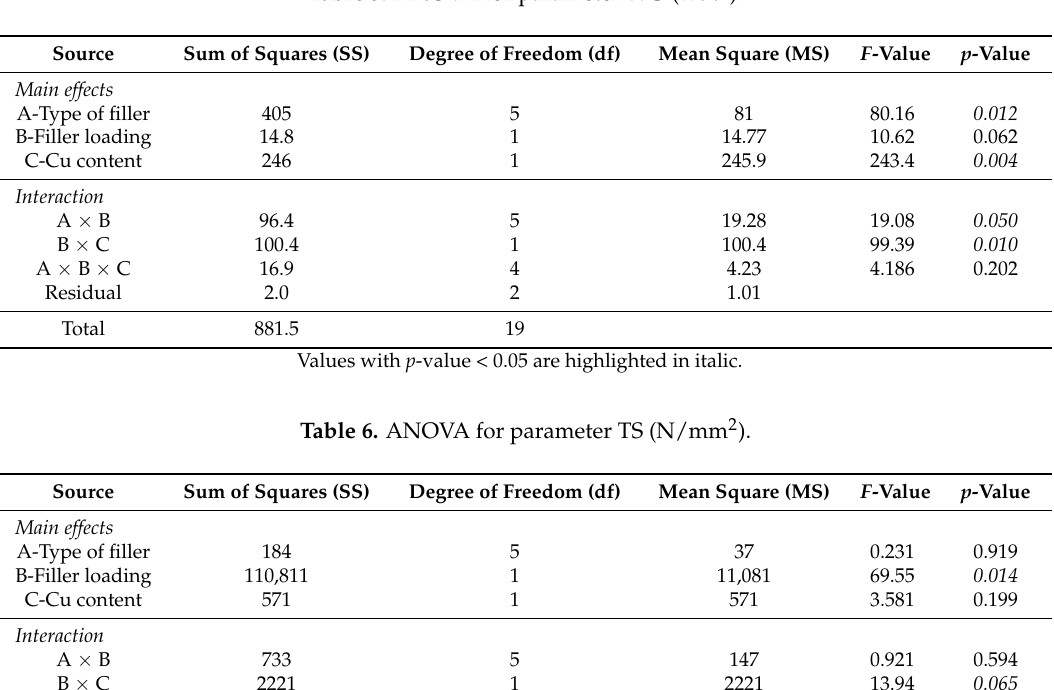
Table 5. ANOVA for parameter WU (wt %).